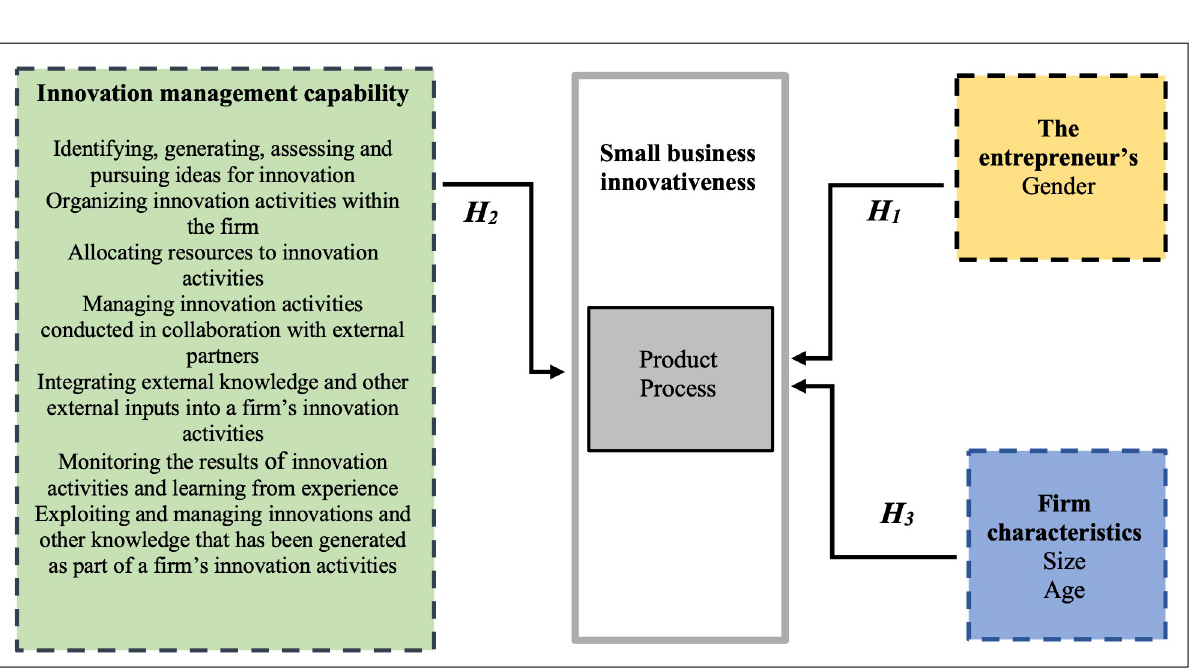
Fig 1. The theoretical model of the